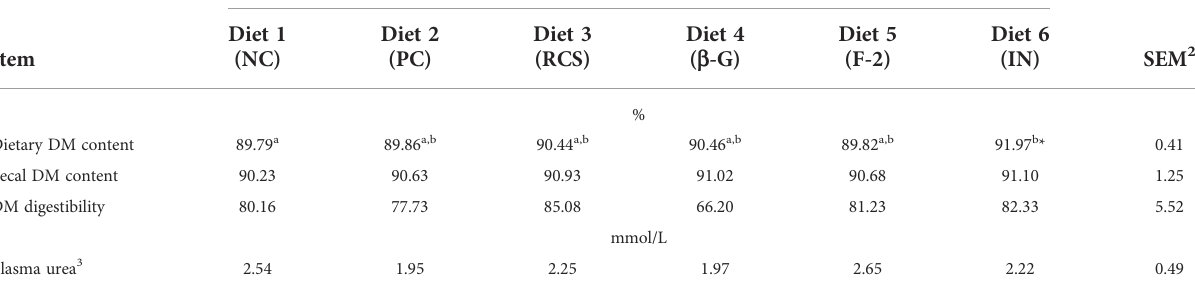
TABLE 3 The effects of dietary supplementation of three prebiotics and b -glucan on the apparent total tract dry matter (DM) digestibility measured during d-8 and d-15 post-weaning and plasma urea concentration determined in d-12 post-weaning in the weanling pigs fed corn and soybean meal-based